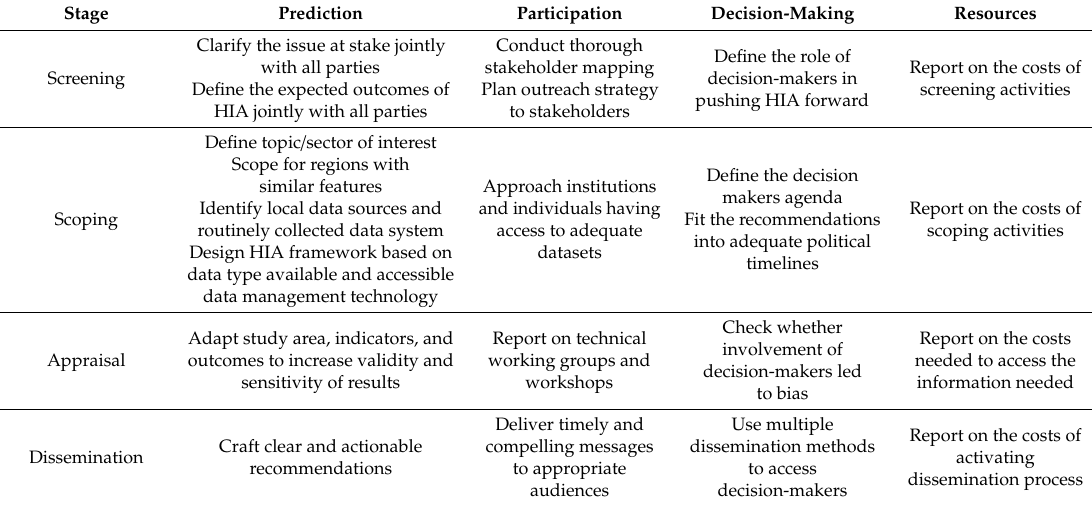
Table 7. Process Appraisal Checklist based on review and adapted from Parry and Kemm (2005) [48].